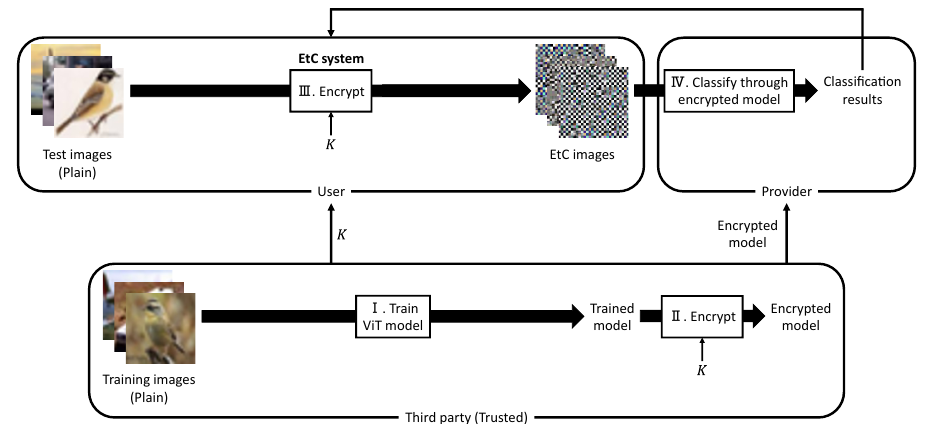
Figure 2. Block diagram of the previous method